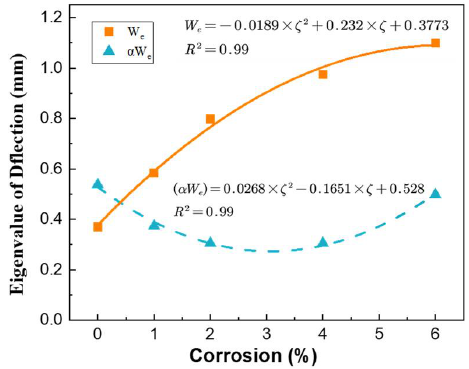
Figure 11. Fitting curve of W e and αW e.